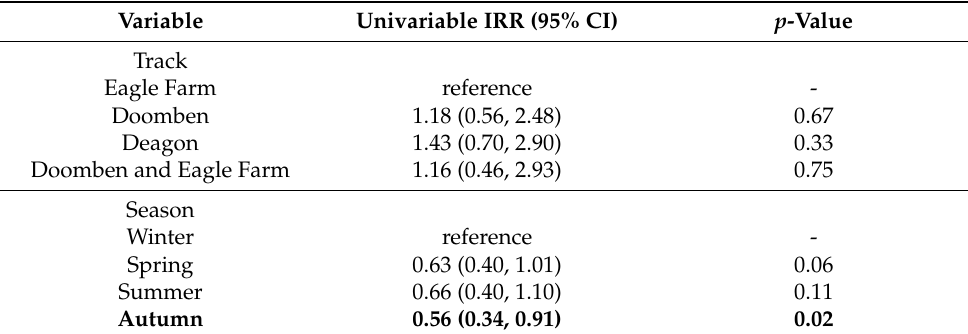
Table 1. The effect of training track and season on the number of retirements in thoroughbred racehorses training in South East Queensland.